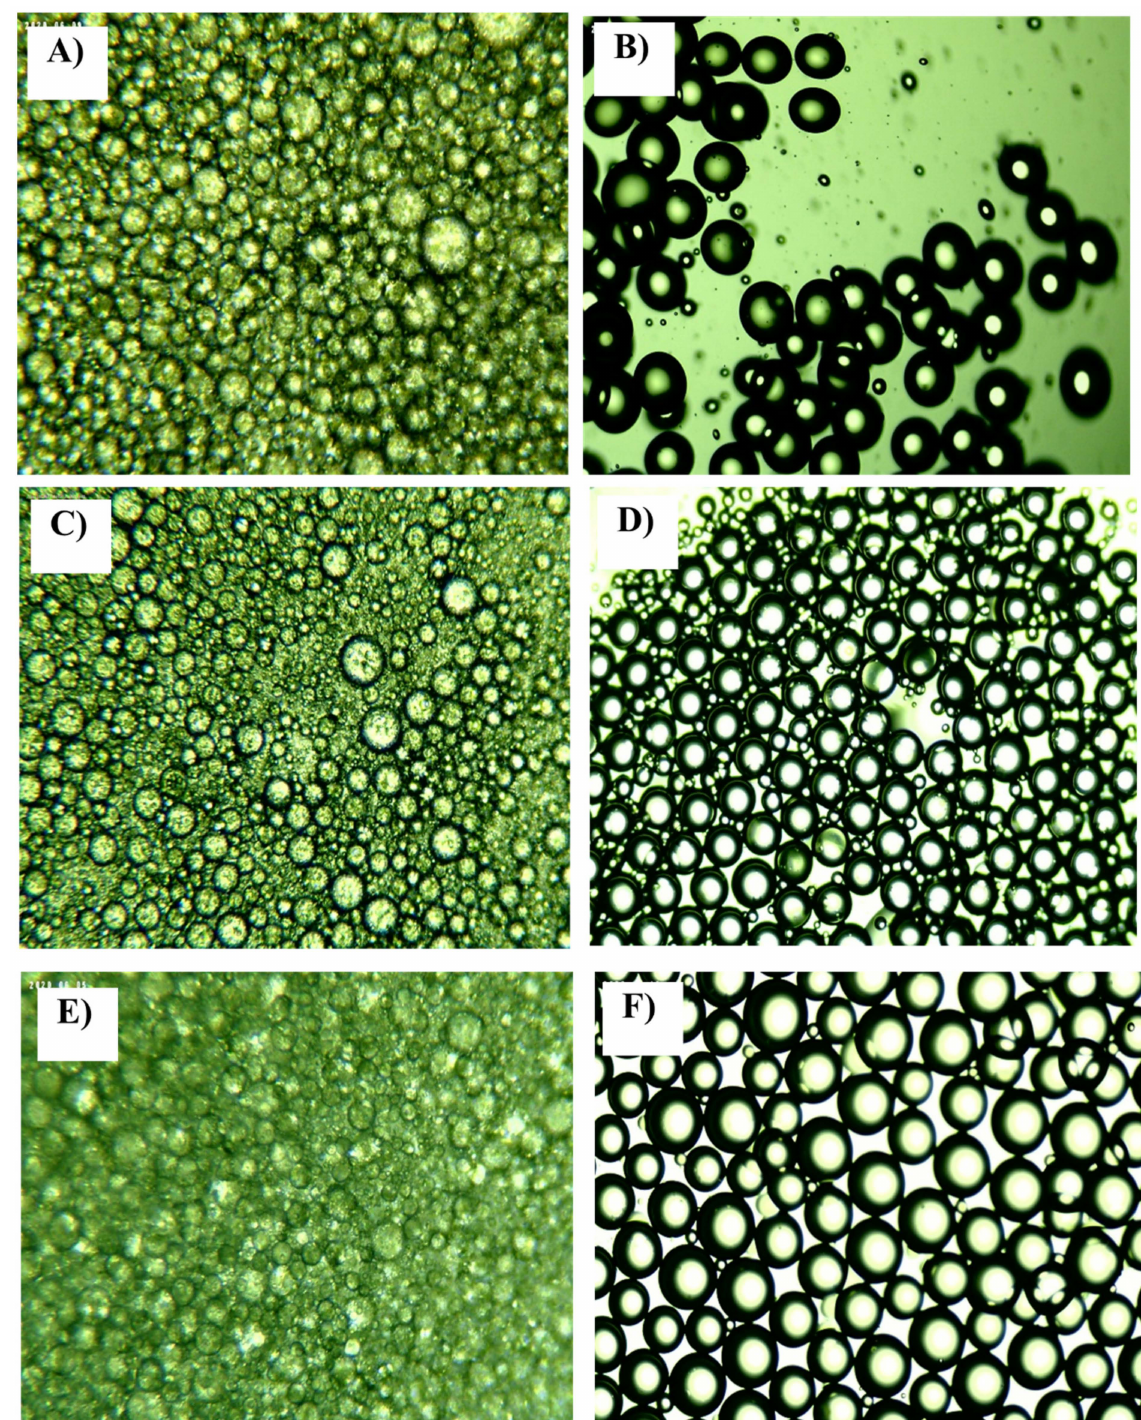
Figure 1. Example of the microscopic images of emulsions: ( A ) batch PEG1500; ( B ) continuous microfluidic PEG1500; ( C ) batch PEG6000; ( D ) continuous microfluidic PEG6000; ( E ) batch PEG20000; ( F ) continuous microfluidic PEG20000. Al microscope images shown are from experiments which represent central points in experimental design: 4% emulsifier, 30% oil phase and mixing rate of 25,000 min − 1 for batch experiments; and 4% emulsifier, 30% oil phase and a total flow rate of 200 µ L/min for the continuous